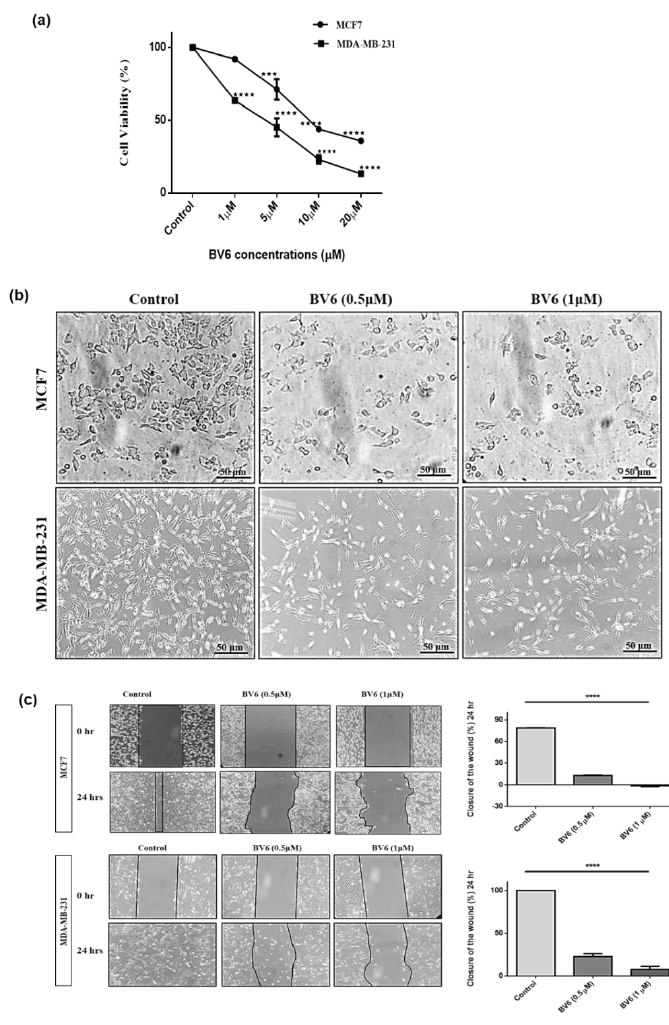
Figure 1. ( a ) BV6 effect on cell viability evaluated by MTT assay: Graph representing that MCF7 and MDA-MB-231 cancer cell viability decreases in a dose-dependent manner. ( b ) Effect of BV6 on MCF7 and MDA-MB-231 cells morphology: untreated cells adhered with normal morphology, whereas treated cells displayed suspended, rounded and shrunken morphology in response to BV6 (40X magnification); scale bar 50 µm. ( c ) Migration by breast cancer cells was assessed by wound/Migration assay with control and 24 hrs BV6 treated groups. Migration of cells is higher in the untreated group, whereas the migration of cancer cells is impeded by an increase in BV6 concentration. Images of MCF7 and MDA-MB-231 cells captured at 0 hr and after 24 hrs of scratch assay showing wound closure in response to BV6 compound along with histogram profile demonstrating the percentage closure of the wound by cells/migration of cells after the 24 hrs of BV6 treatment compared to untreated control cells. Data represented is statistically significant (***) and (****) show p ˂ 0.001, and p ˂ 0.0001 respectively and is carried out in triplicates displayed as mean ± SEM.